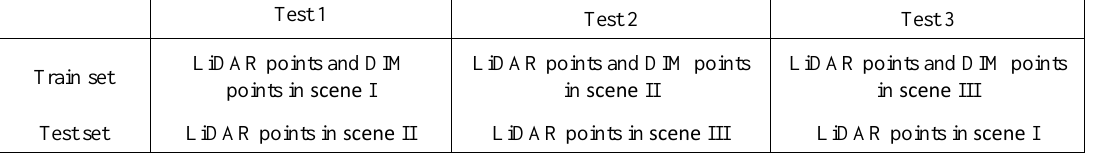
Table 2. Train set and test set in three